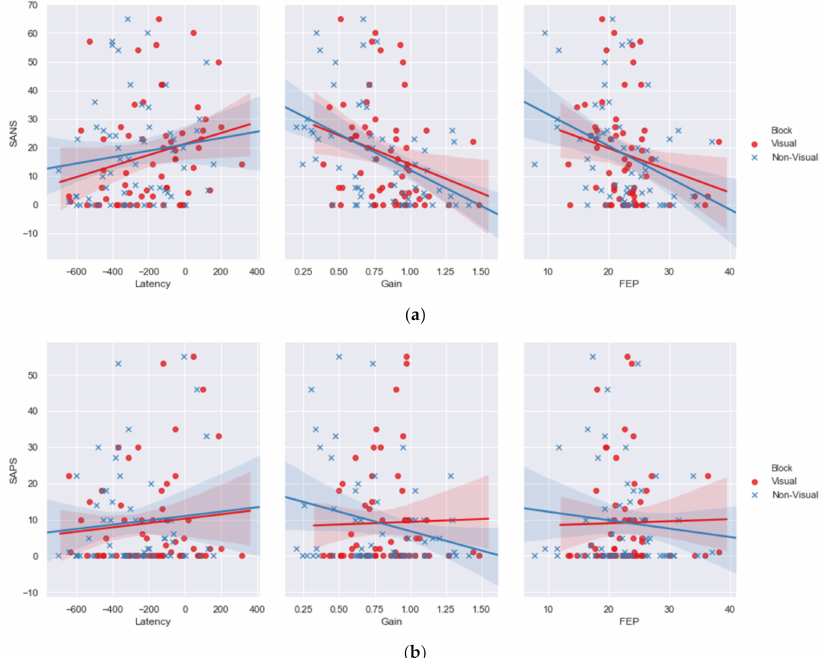
Figure 4. ( a ) Negative correlational relationships were observed between negative symptoms and performance in the visual and non-visual blocks in terms of gain and final eye position measures, and positive relationships between latency and negative symptoms. ( b ) Negative correlational relationships were observed between positive symptoms and performance in the visual and non- visual blocks in terms of gain and final eye position